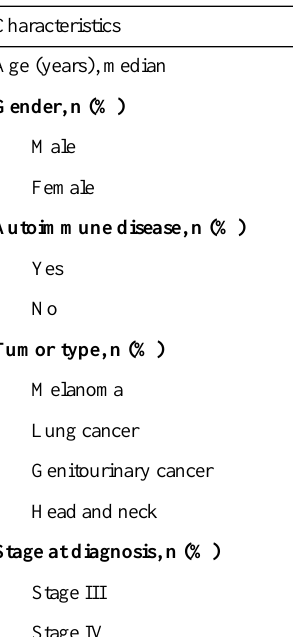
Table 1. Patient